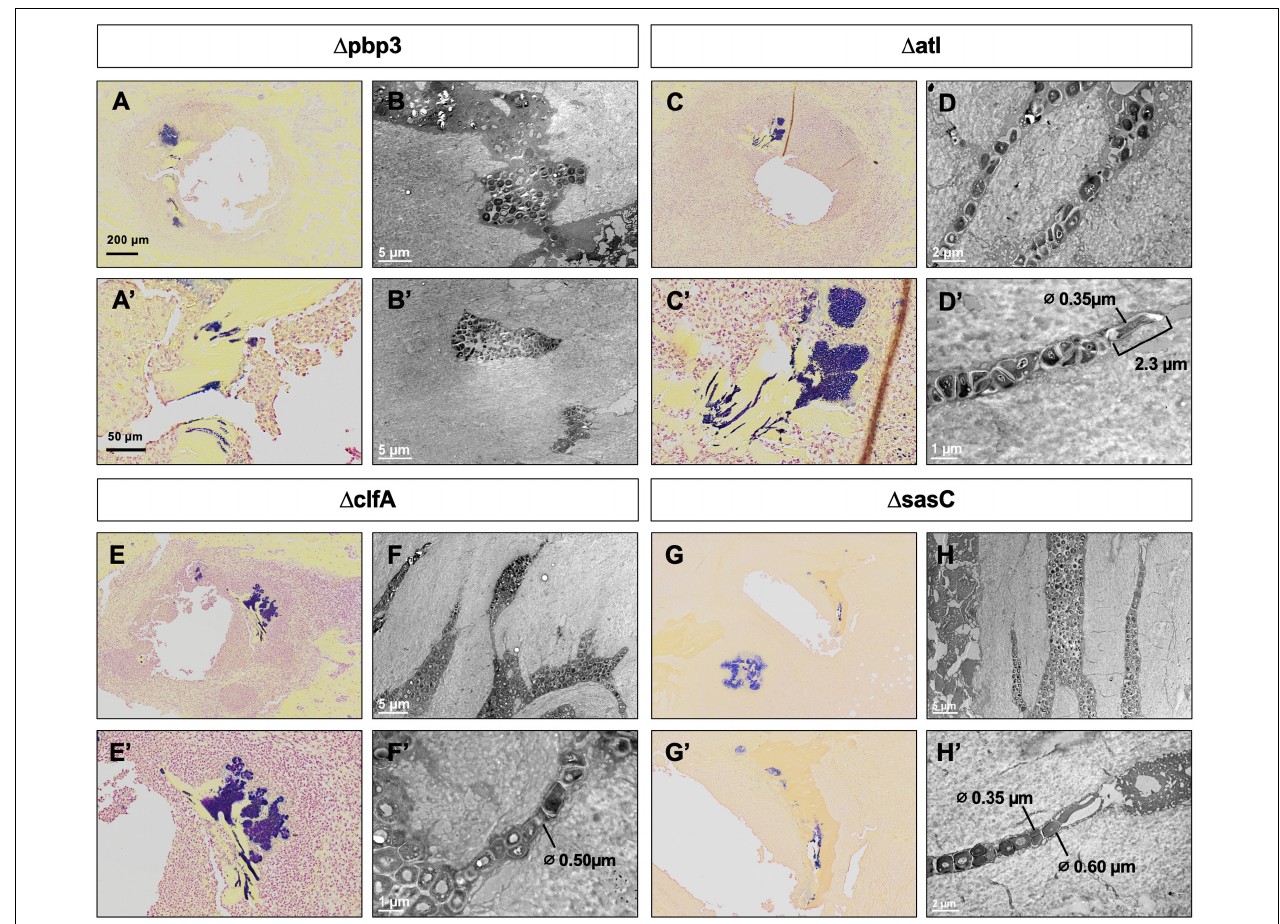
FIGURE 6 | Pbp3 deletion eliminates S. aureus OLCN invasion in a murine model of implant-associated osteomyelitis. Brown–Brenn–stained histology sections were used to identify necrotic bone fragments containing gram-positive bacteria (purple) in tibiae infected with (cid:49) pbp3, (cid:49) atl, (cid:49) clfA, and (cid:49) sasC S. aureus , and adjacent tissue sections ( n = 3 tibiae per group) were used for ultrastructural analysis via the TEM “pop-off” method to formally interrogate OLCN invasion. Representative images of Brown–Brenn histologic sections (A,C,E,G) and TEM micrographs are shown for each infection genotype (B,D,F,H) . Pbp3 deletion does not eliminate S. aureus colonization of the bone (A,A’) . However, (cid:49) pbp3 bacteria colonization appears to be limited to microcracks (B) and blood vessel canals (B’) but were not found in submicron canaliculi. On the other hand, deletion of atl, clfA, and sasC does not inhibit S. aureus invasion of canaliculi (C–H) . Note the submicron deformation ( , cell diameters are measured where indicated) and linearized propagation of (cid:49) atl, (cid:49) clfA, and (cid:49) sasC cells within bone canaliculi (D’,F’,H) . Note the extreme deformation of (cid:49) atl S. aureus cells at the leading edge of invasion, measuring at 0.35 µ m in diameter and 2.3 µ m in length (D’) . (cid:31) TABLE 2 | Evaluation of S. aureus deletion mutant bone infection phenotypes.